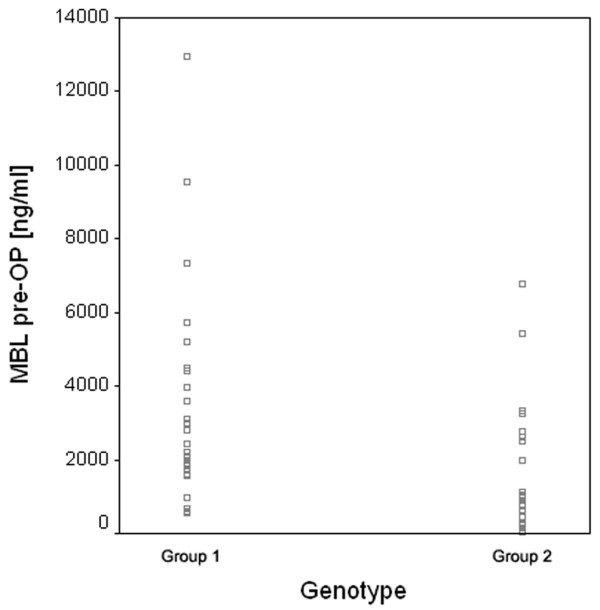
Correlation between MBL genotype group and MBL serum levels. Preoperative (pre-OP) mannan-binding lectin (MBL) levels in patients homozygous for the wild-type except the AX/AX type (group 1), and carriers of variations in exon 1 (A/O and O/O type) and the AX/AX type (group 2). Spearman rank correlation coefficient between genotype and preoperative serum MBL = -0.32, p = 0.02.